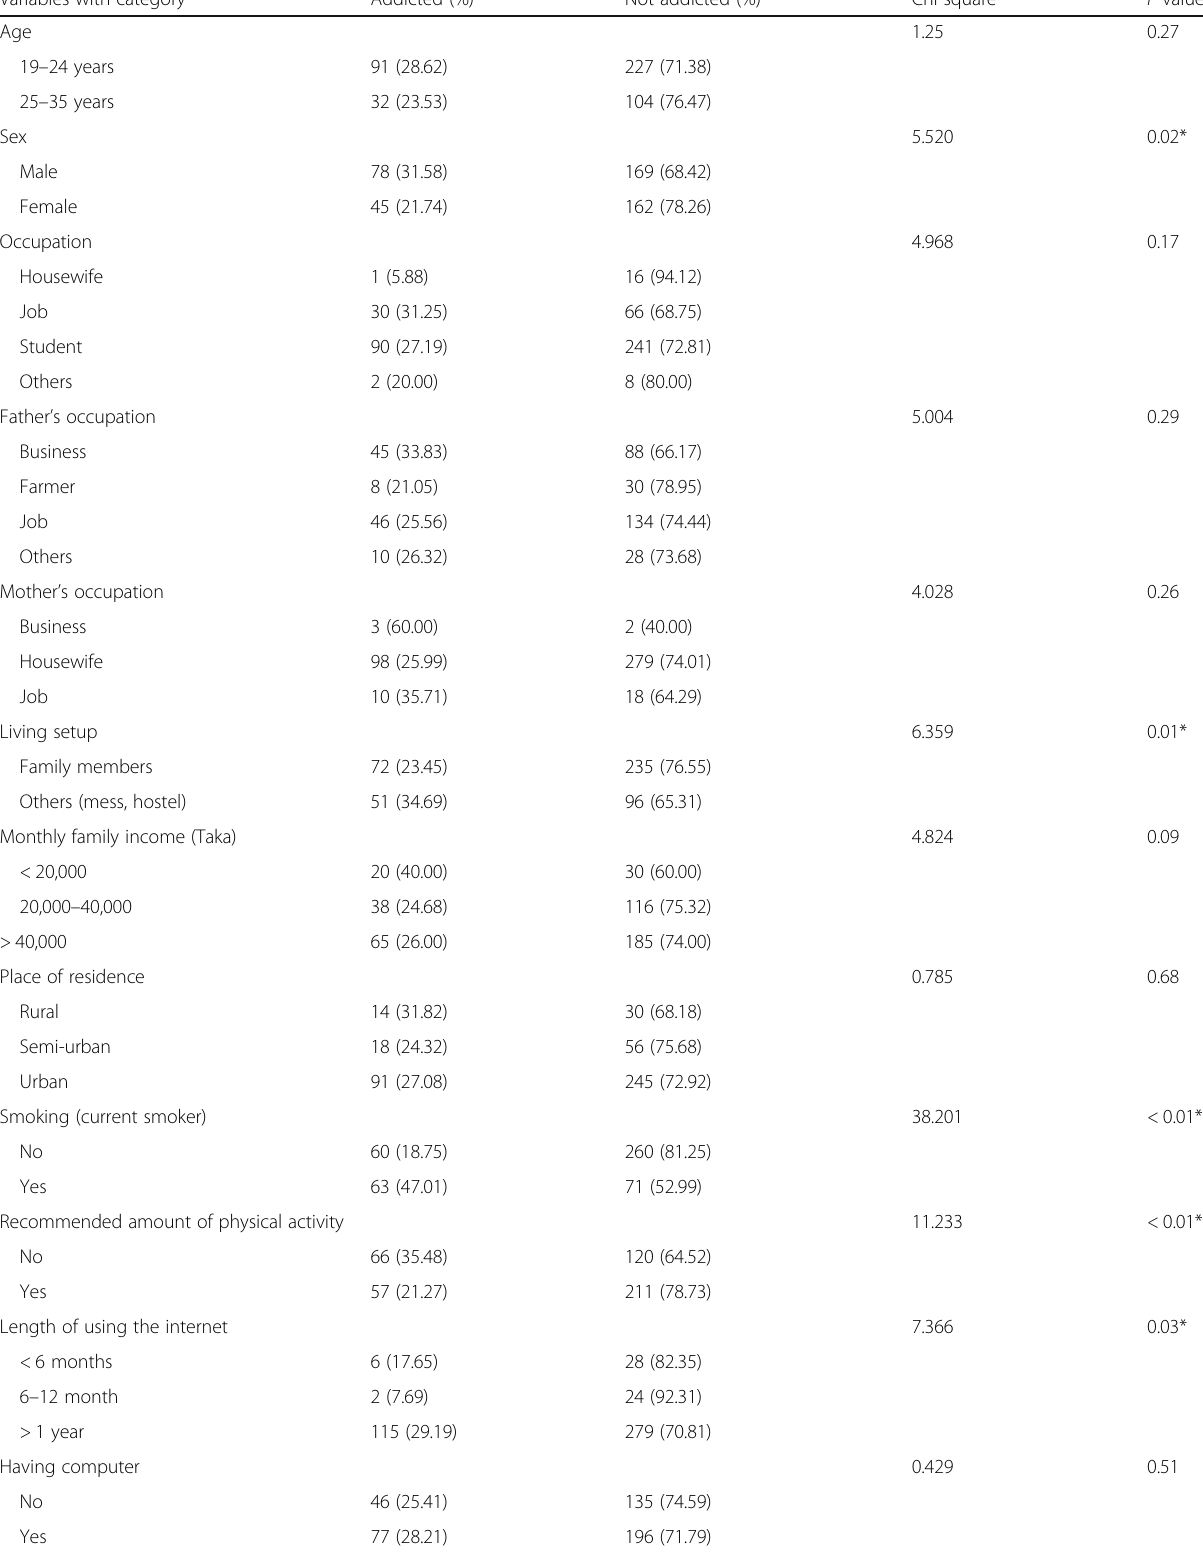
Table 3 Association of socio-demographic and activity related characteristics of internet users with internet addiction Variables with